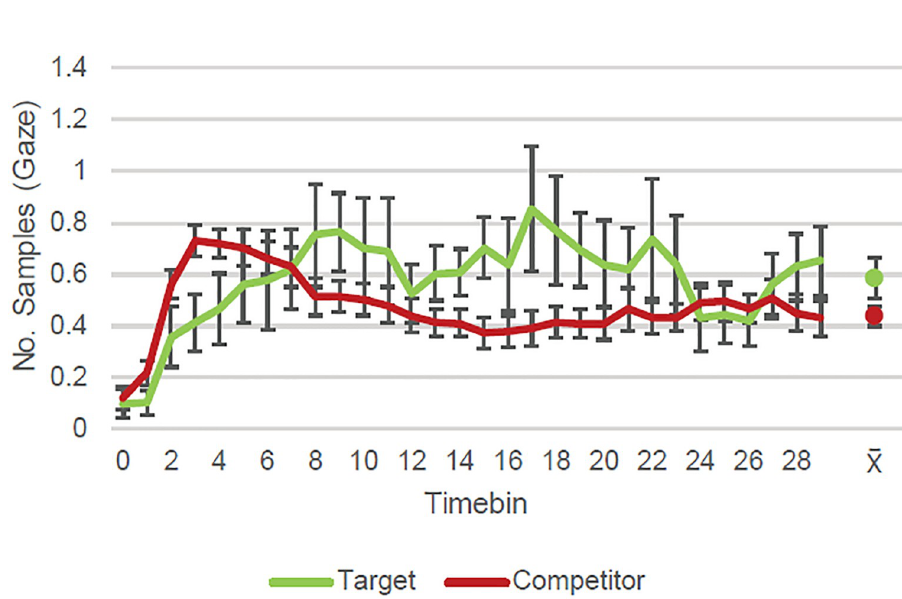
Fig 5. Failed recognition. In the time window of interest (starting at timebin 5; 500 ms after stimulus onset), participants looked more to the correct target quadrant than to the competitors when they failed to recognize the cue and incorrectly labeled it as being new. The graph shows eye tracking samples (per trial/per subject) with gaze detected (and S . E . of the mean) during retrieval according to quadrant content for trials with failed cue recognition. Data aggregated on 100 ms time bins. The dots represent each line’s average (and S . E .) across the time window of interest (timebins 5–29).